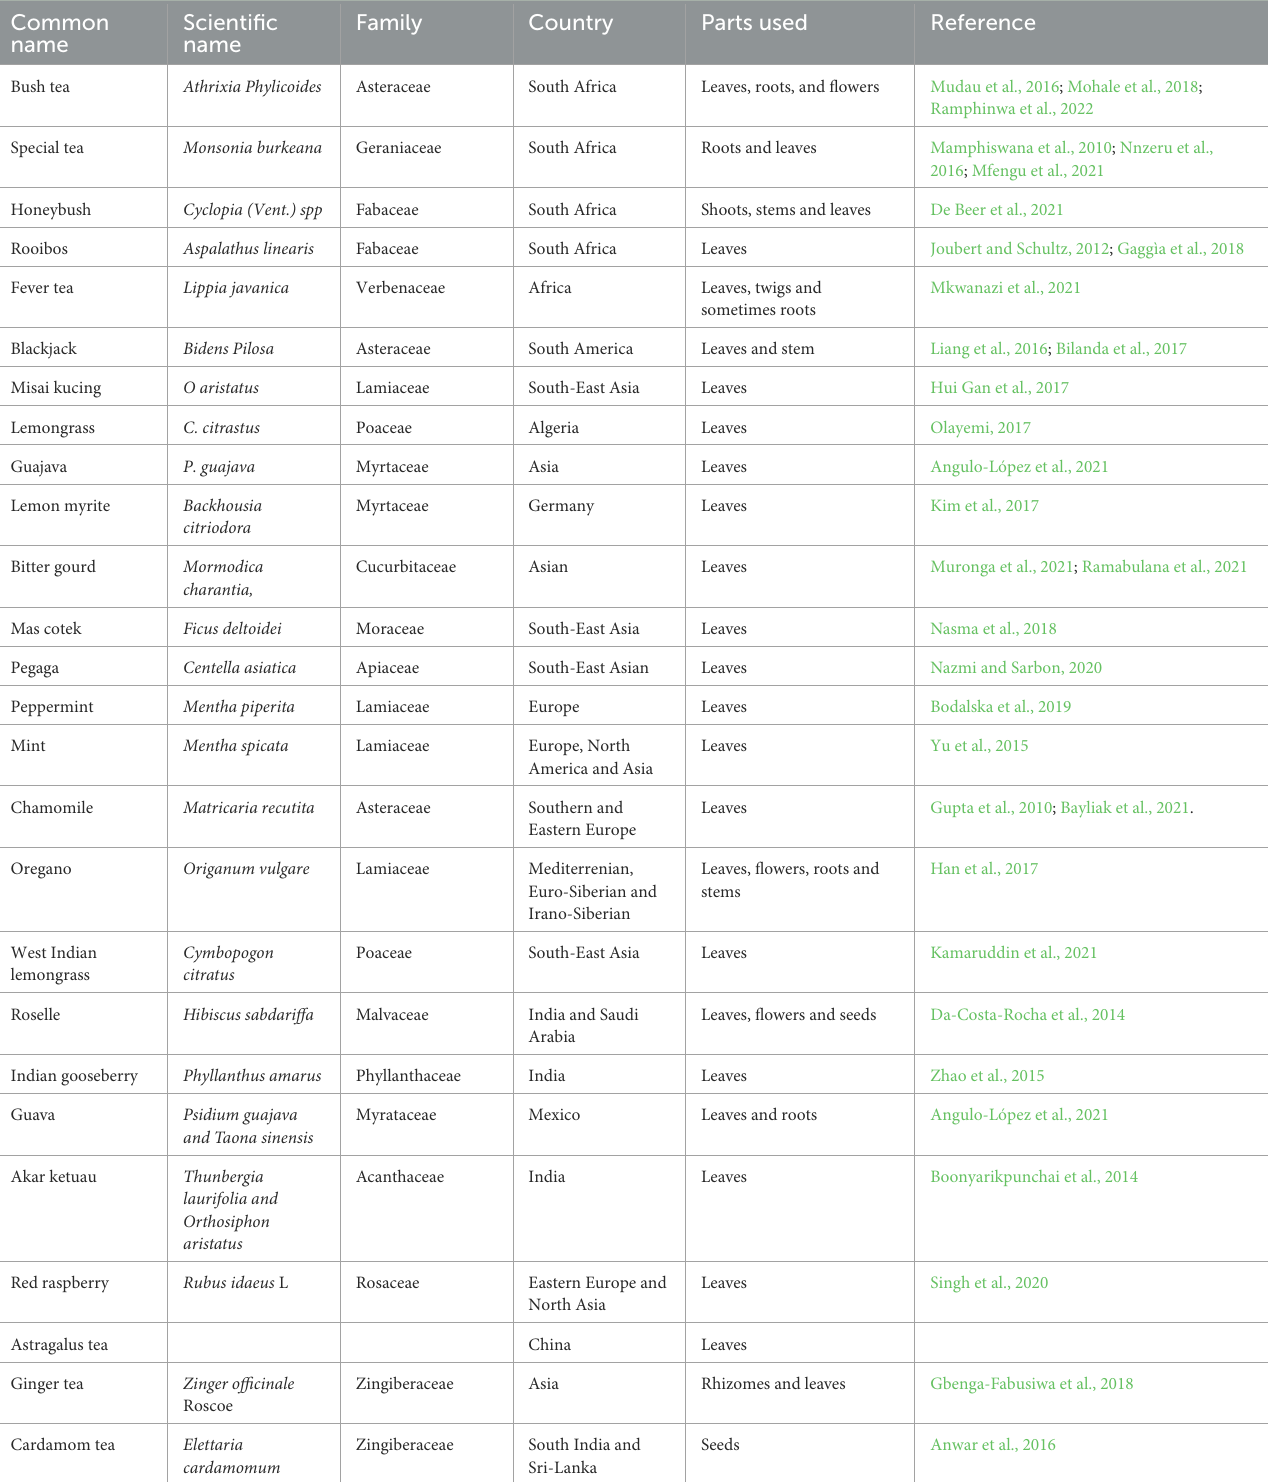
TABLE 1 Different types of herbal teas used